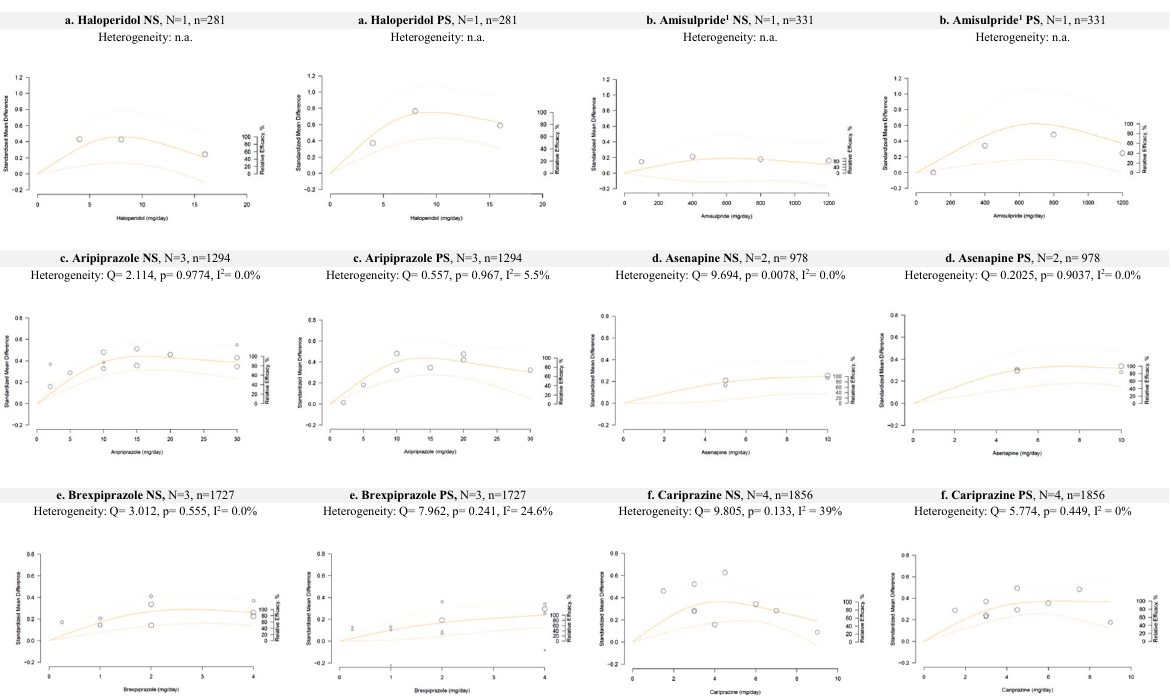
Fig. 1 Dose-response curves for haloperidol, amisulpride, aripiprazole, asenapine, brexpiprazole and cariprazine regarding negative symptoms (NS) or positive symptoms (PS). The fi gures represent pooled dose-response association for each antipsychotic and the mean change in the negative subscale (left) and the positive subscale (right) scores of the PANSS (solid line). Dash lines represent the 95% con fi dence intervals for the restricted cubic spline model. The placebo group (dose = 0) served as the referent group. Circles indicate observed mean differences in individual studies; size of bubbles is proportional to precision (inverse of variance) of the standardized mean differences. The right y -axis represents percentage of the maximum predicted effect. (1) No placebo arm was available for amisulpride. We considered the 100 mg arm as comparator for this sensitivity analysis.